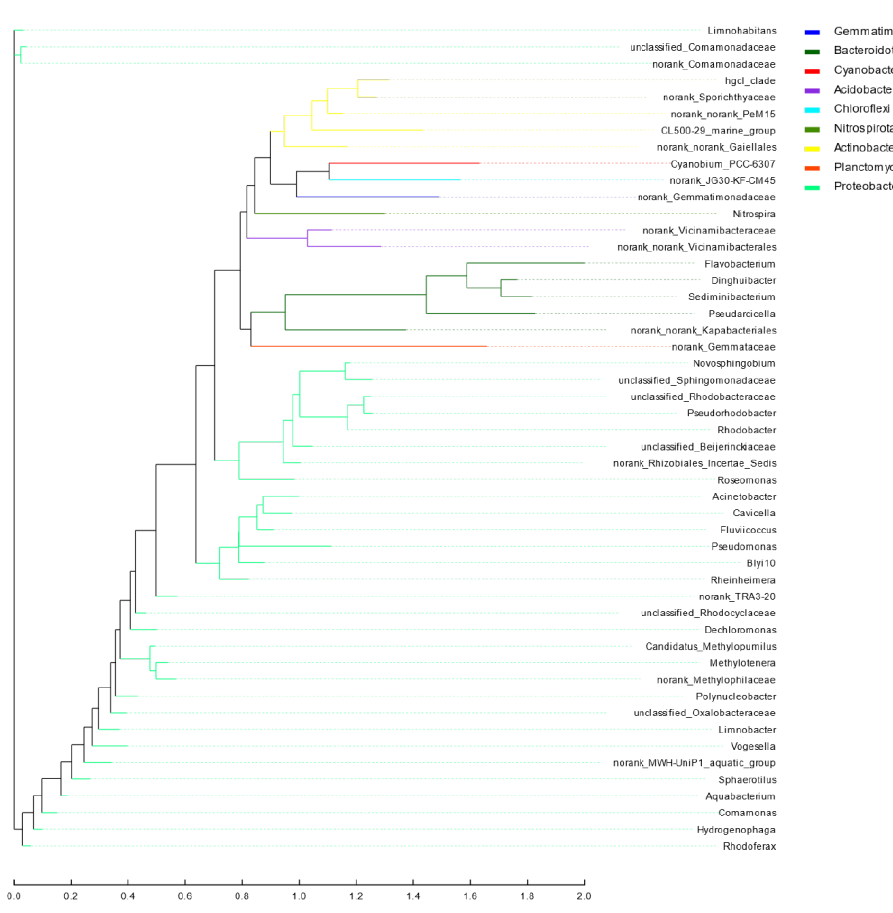
Figure 10. Phylogenetic tree analysis on genus level. (Each branch represents a species and the length of the branch represents the evolutionary distance.).